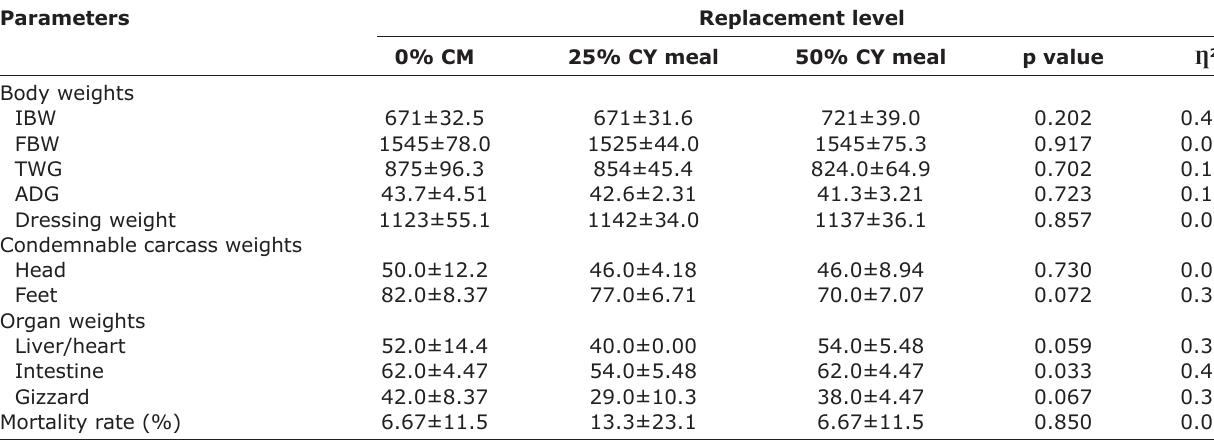
Table-3: Mean values (±SD) on growth rates of finisher broilers fed with varying amounts of cocoyam meal as partial carbohydrate replacement for maize. Parameters